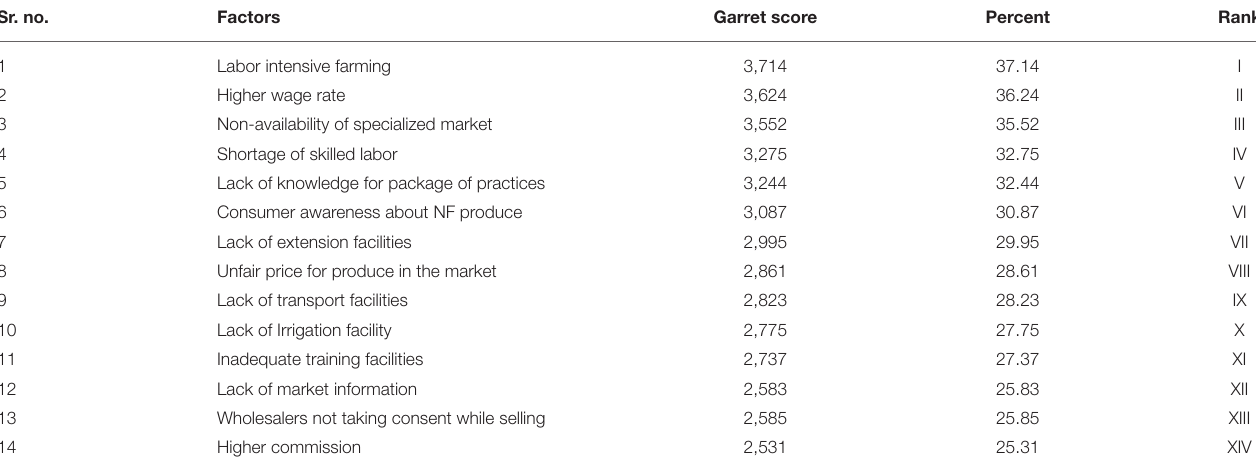
TABLE 19 | Farmers’ perceptions and problems faced by NF growers in the study area. Sr.